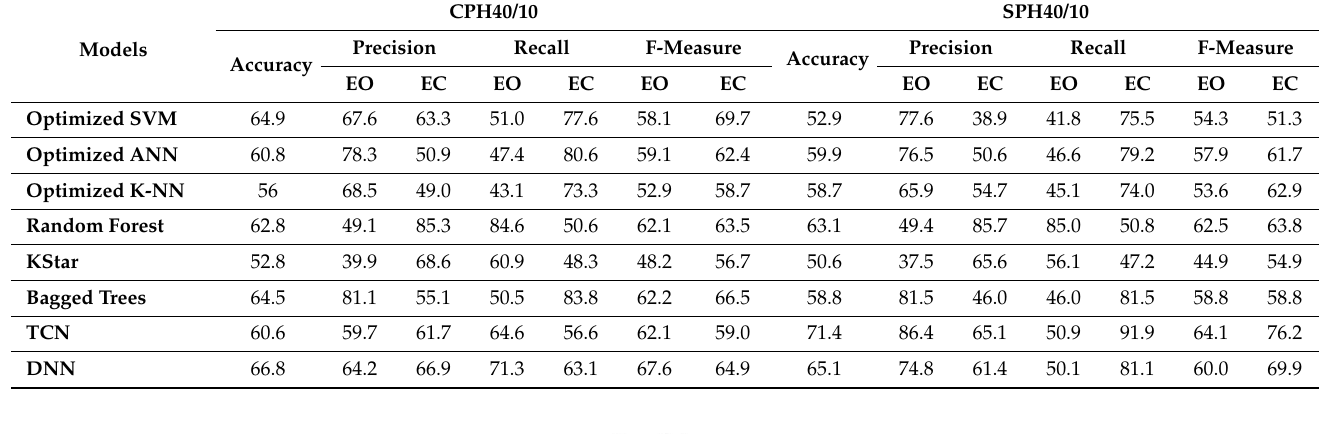
Table A6. The performance of models on evaluation measures (“Precision”, “Recall” and “F- measure”) for “comprehensively” and “simply” preprocessed datasets based on train/test split method: 40 subjects for train/10 subjects for test. CPH40/10: CP40-M and CP10; SPH40/10: SP40-M and SP10.